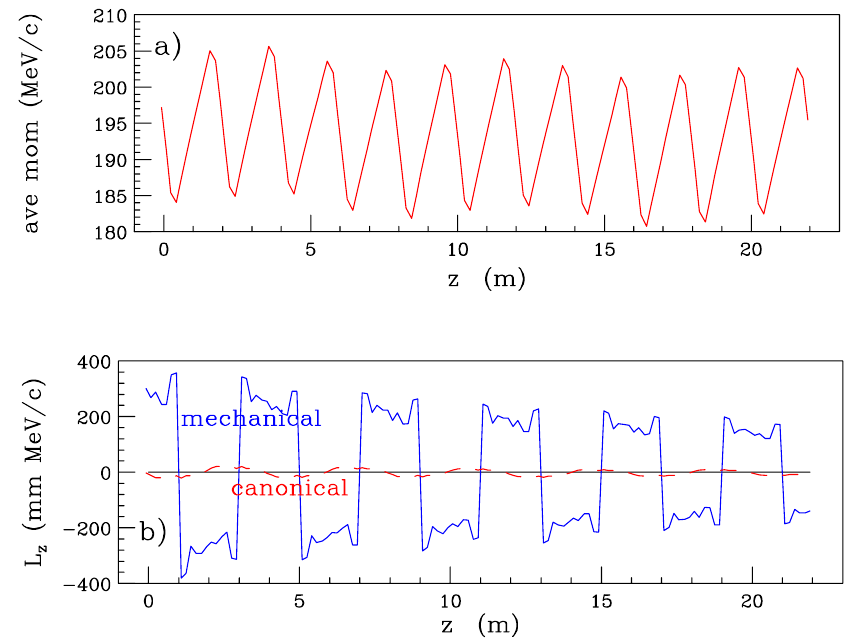
FIG. 26. (Color) (a) Average momentum vs z , (b) average angular momentum: mechanical (solid curve) and canonical (dashed curve) vs z